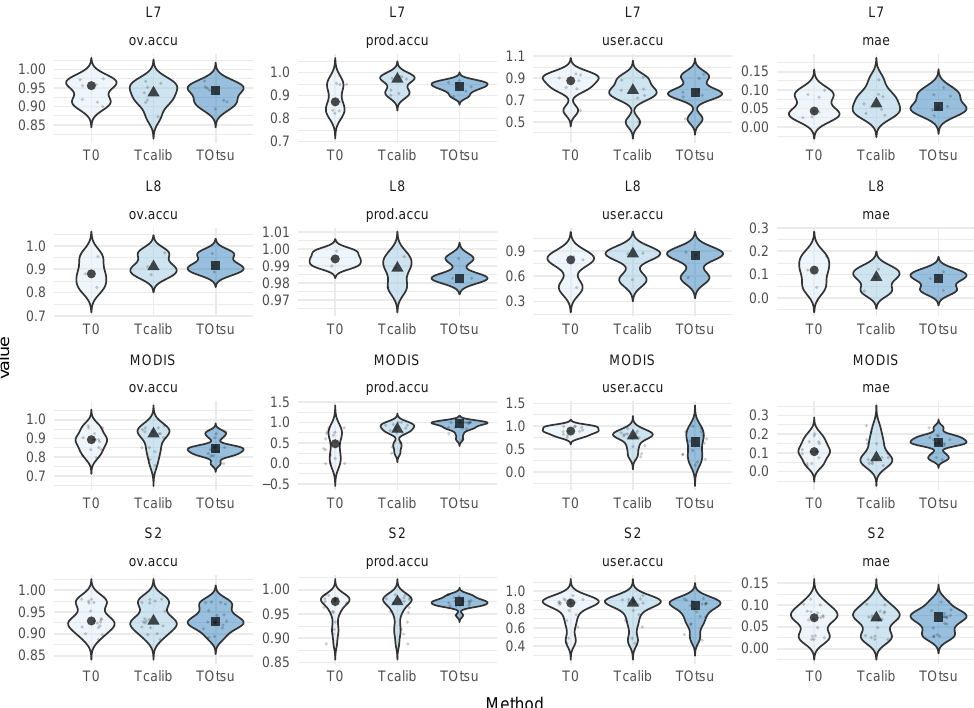
Figure 7. Violin box plots of four accuracy metrics for three MNDWI classification methods on imagery from four sensors over the 2017 and 2019